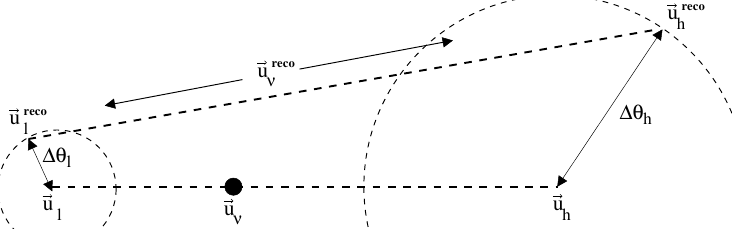
Figure 10 . Sketch illustrating the reconstruction of a neutrino direction ~u (cid:23) . The true lepton and hadronic directions, ~u l and ~u h , are reconstructed in directions ~u reco errors (cid:1) (cid:18) l and (cid:1) (cid:18) h . The reconstructed neutrino direction, ~u reco